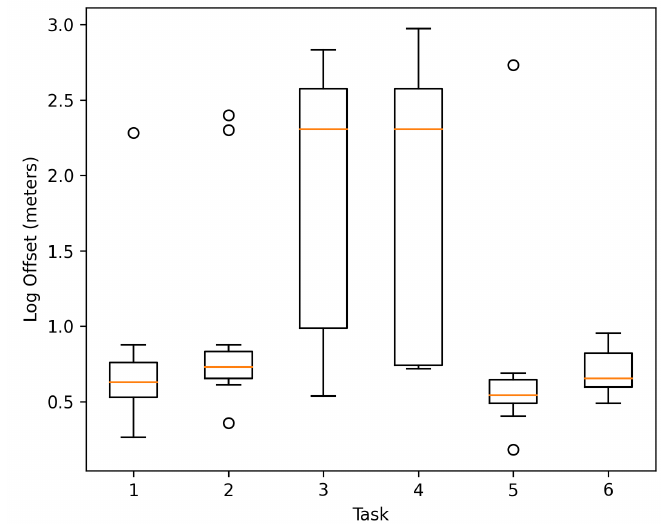
Figure 6. Log distance offset registered by the system while performing the navigation